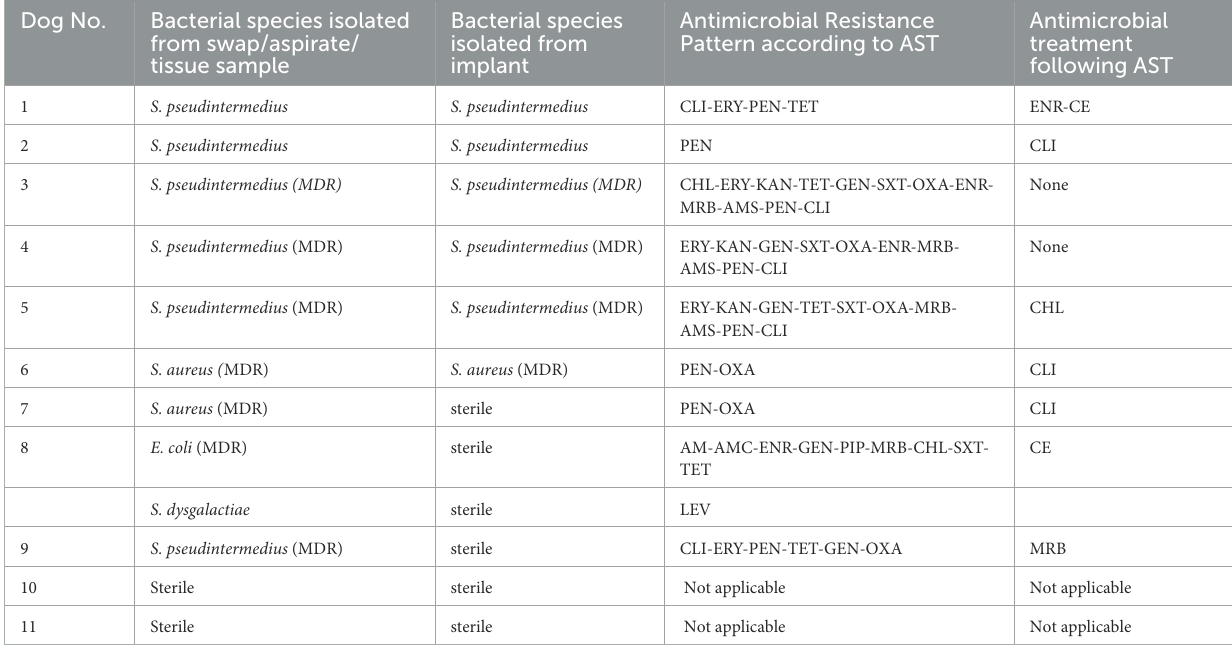
TABLE 6 Bacterial species and antimicrobial resistance pattern, antimicrobial treatment, and occurrence of complicated infection in 11 dogs with paired bacterial culture. Dog No. Bacterial species isolated from swap/aspirate/ tissue sample